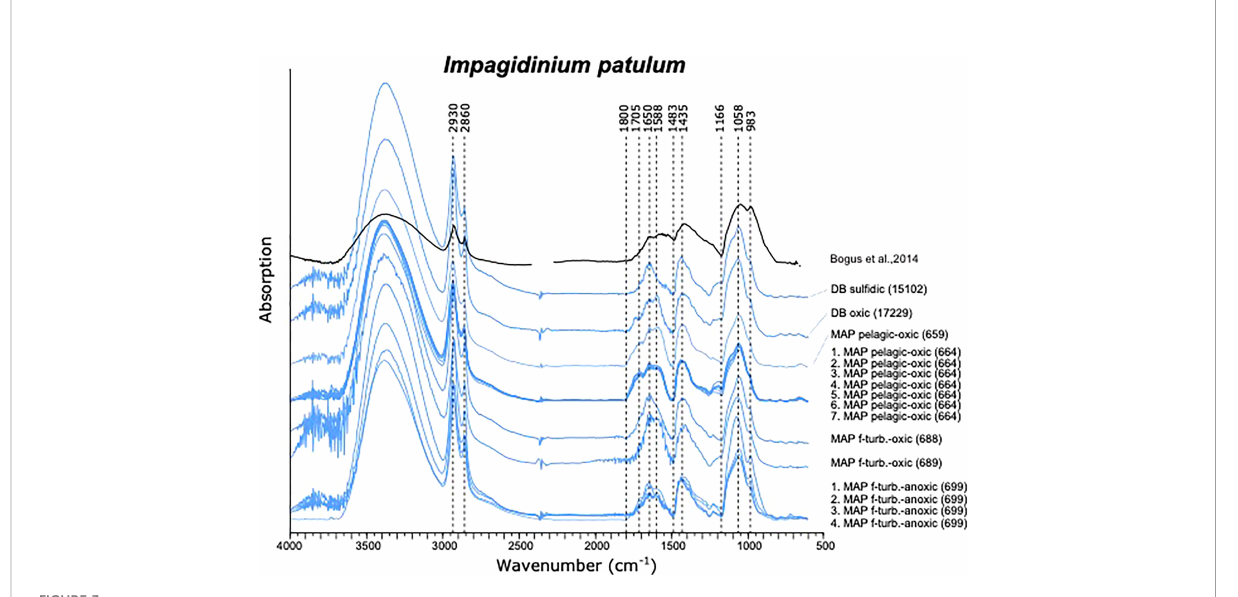
FIGURE 3 Micro-FTIR spectra of Impagidinium